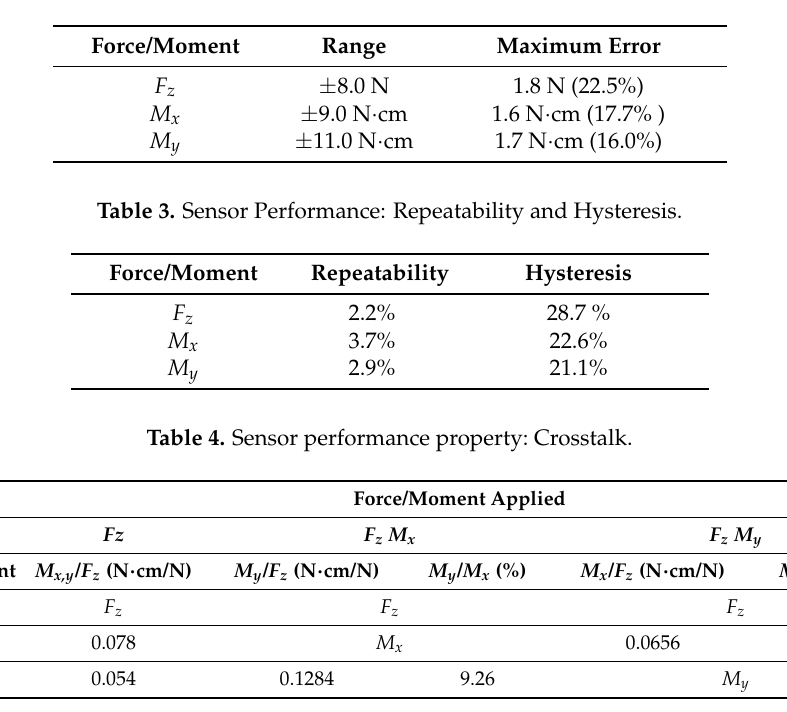
Table 2. Sensor Performance Property: Range and Error.